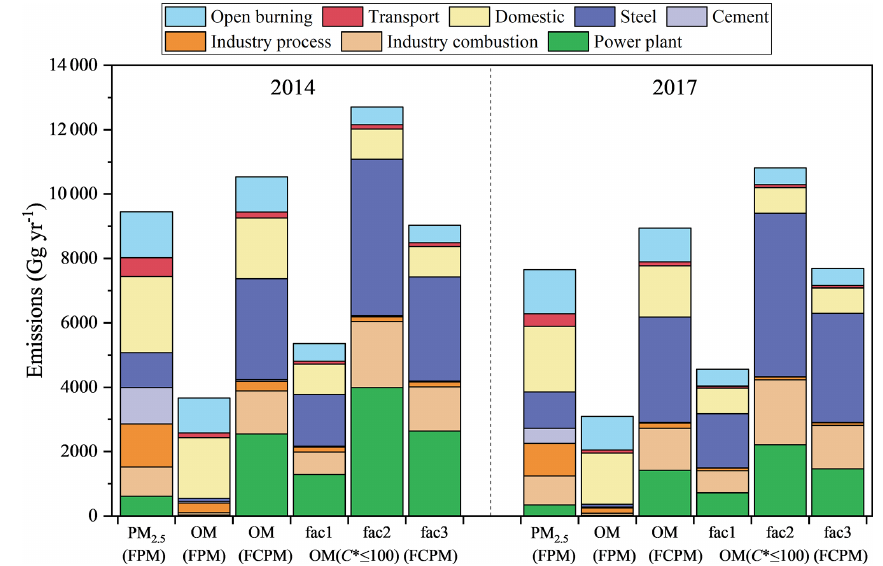
Figure 2. Annual emissions of PM 2 . 5 and OM in filterable particulate matter (FPM), OM in filterable and condensable particulate mat- ter (FCPM) before the application of volatility distributions, and OM ( C ∗ ≤ 100µgm − 3 ) in FCPM after the application of the volatility distributions for the fac1, fac2, and fac3 cases over China in 2014 and 2017.